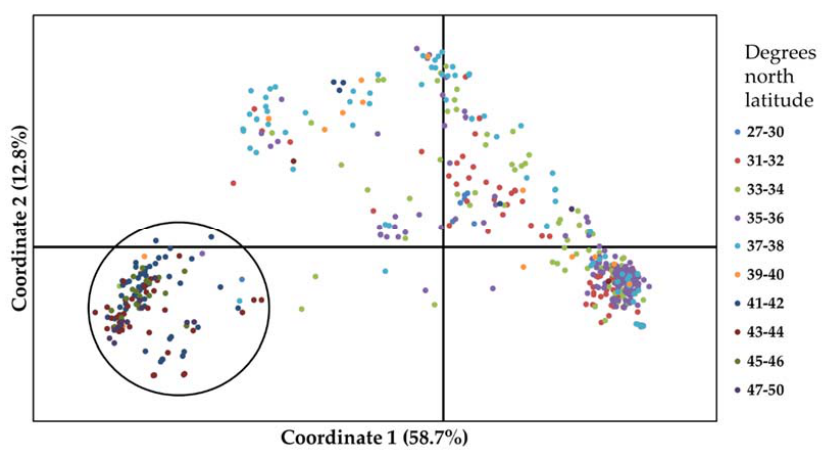
Figure 1. Principal coordinates analysis (PCoA) based on 5476 SNP markers on 553 winter wheat landraces. Landraces are color coded based on ranges of latitudes of their origin. The circled accessions indicate clustering of most of the accessions from ≥ 40° north latitude. Table 1. Genome-wide association studies results showing significant SNPs for population structure, latitude, and electrolyte leakage (as a measure of freezing tolerance) in winter wheat landraces. SNP a CHR b cM c MAF d Obs e p -Value Trait Possible Gene Identification f Population IWA3431 2A 117.57 553 3.02 × 10 − 124 Translation initiation factor structure Population Unknown function, 1.11 × 10 − 107 structure transmembrane domains phosphatidylinositol IWA7271 553 1.02 × 10 − 50 Latitude N- acetyglucosaminyltransferase 6A 85.53 0.41 192 1.52 × 10 −